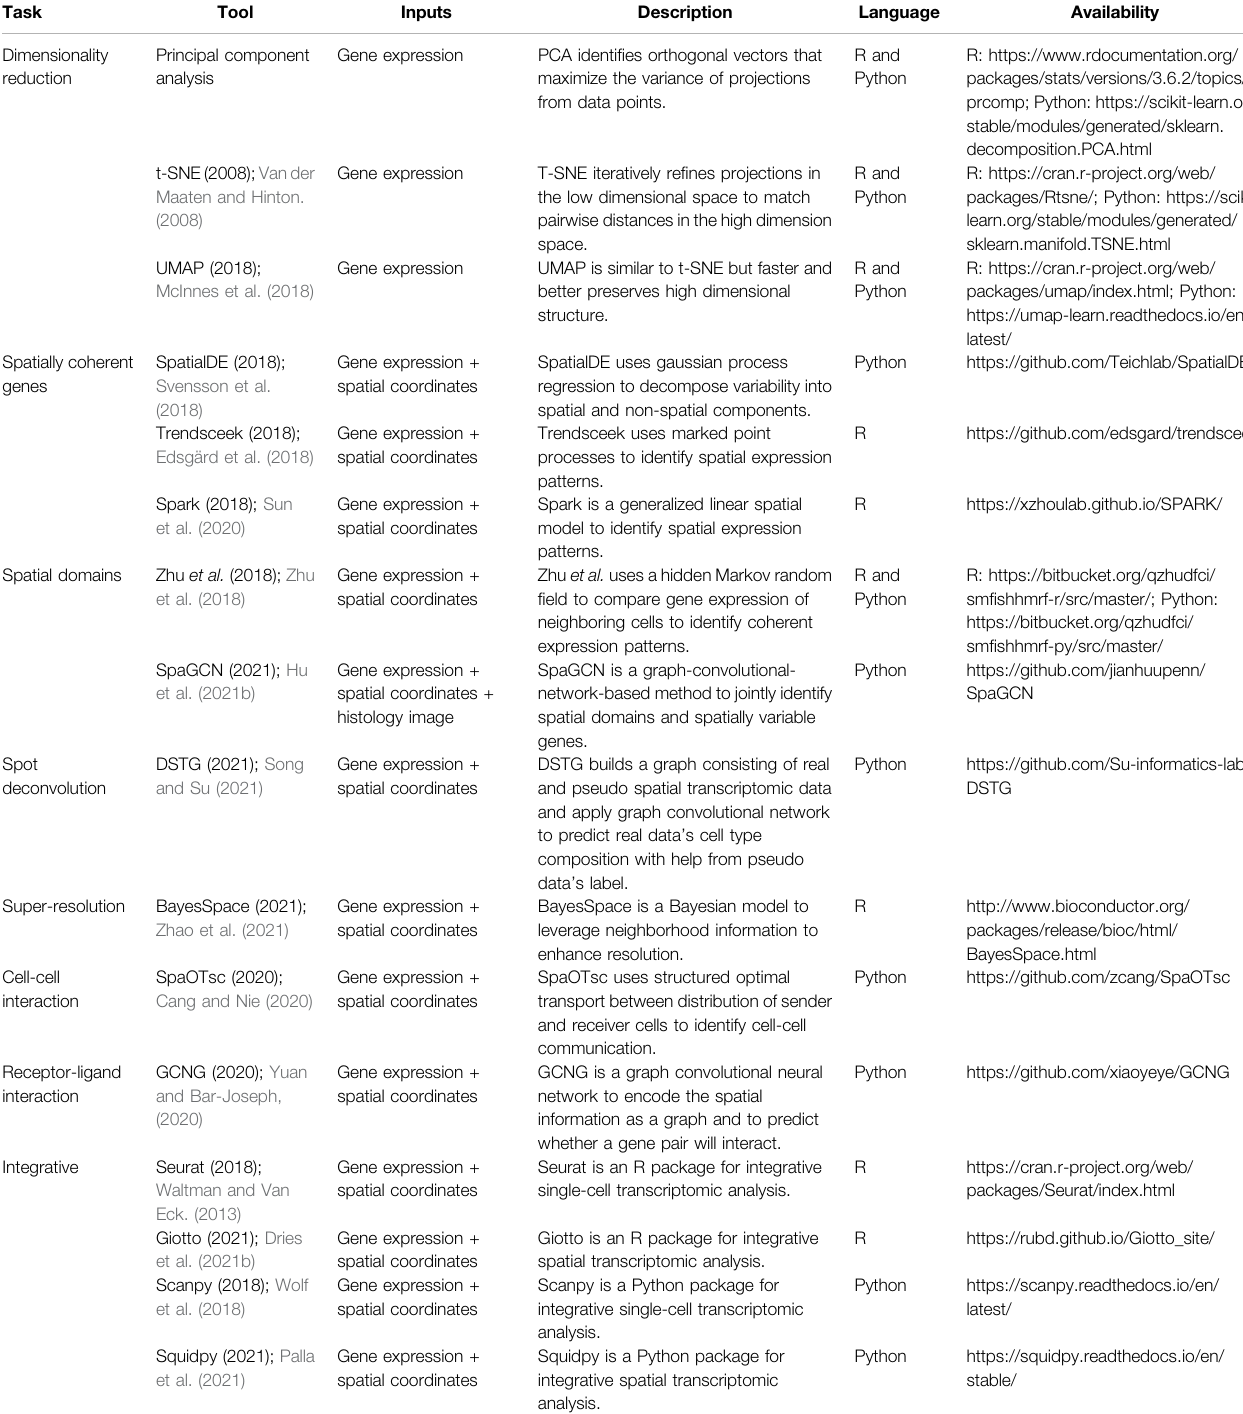
TABLE 1 | ( Continued ) Current analysis and visualization tools for spatial transcriptomic datasets (accession date: